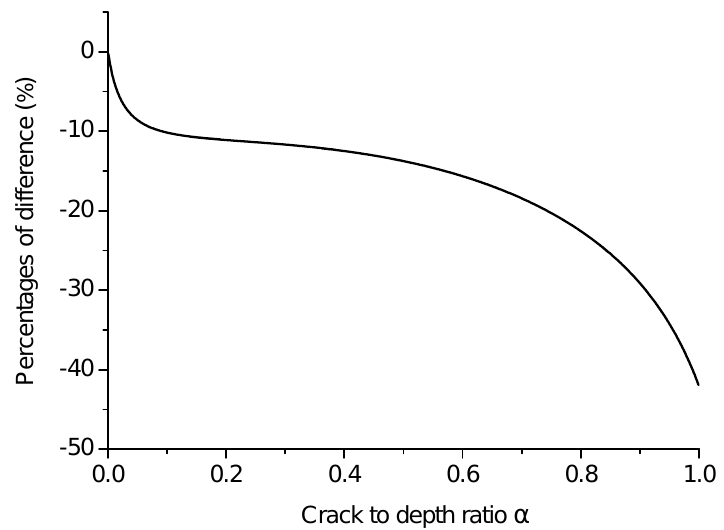
Figure A4. Percentages of the difference of the nominal strength given by the boundary effect model and the proposed